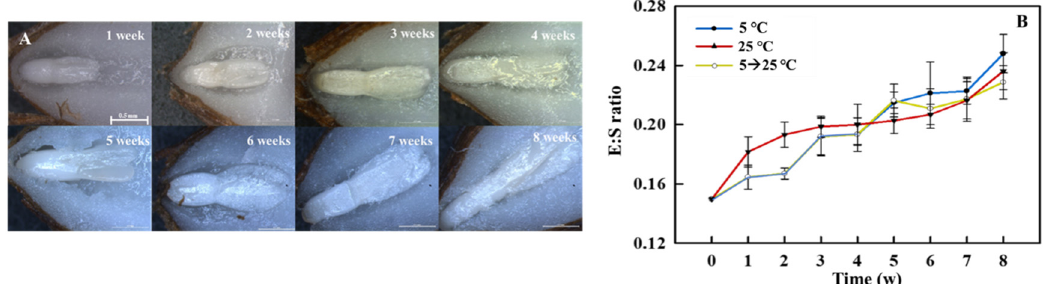
Figure 3. ( A ) Microscopic images of cold (5 °C) stratification-treated embryo development of a coastal glehnia seed over eight weeks. Reference bars represent 0.5 mm. ( B ) Ratio of embryo to seed (E:S ratio) of coastal glehnia seeds for eight weeks of cold (5 °C) and warm (25 °C) stratification treatment, and cold (5 °C) stratification for five weeks before being moved to warm (25 °C) stratification treatment for three weeks (5 → 25 °C). The vertical bars indicate standard errors ( n = 10).